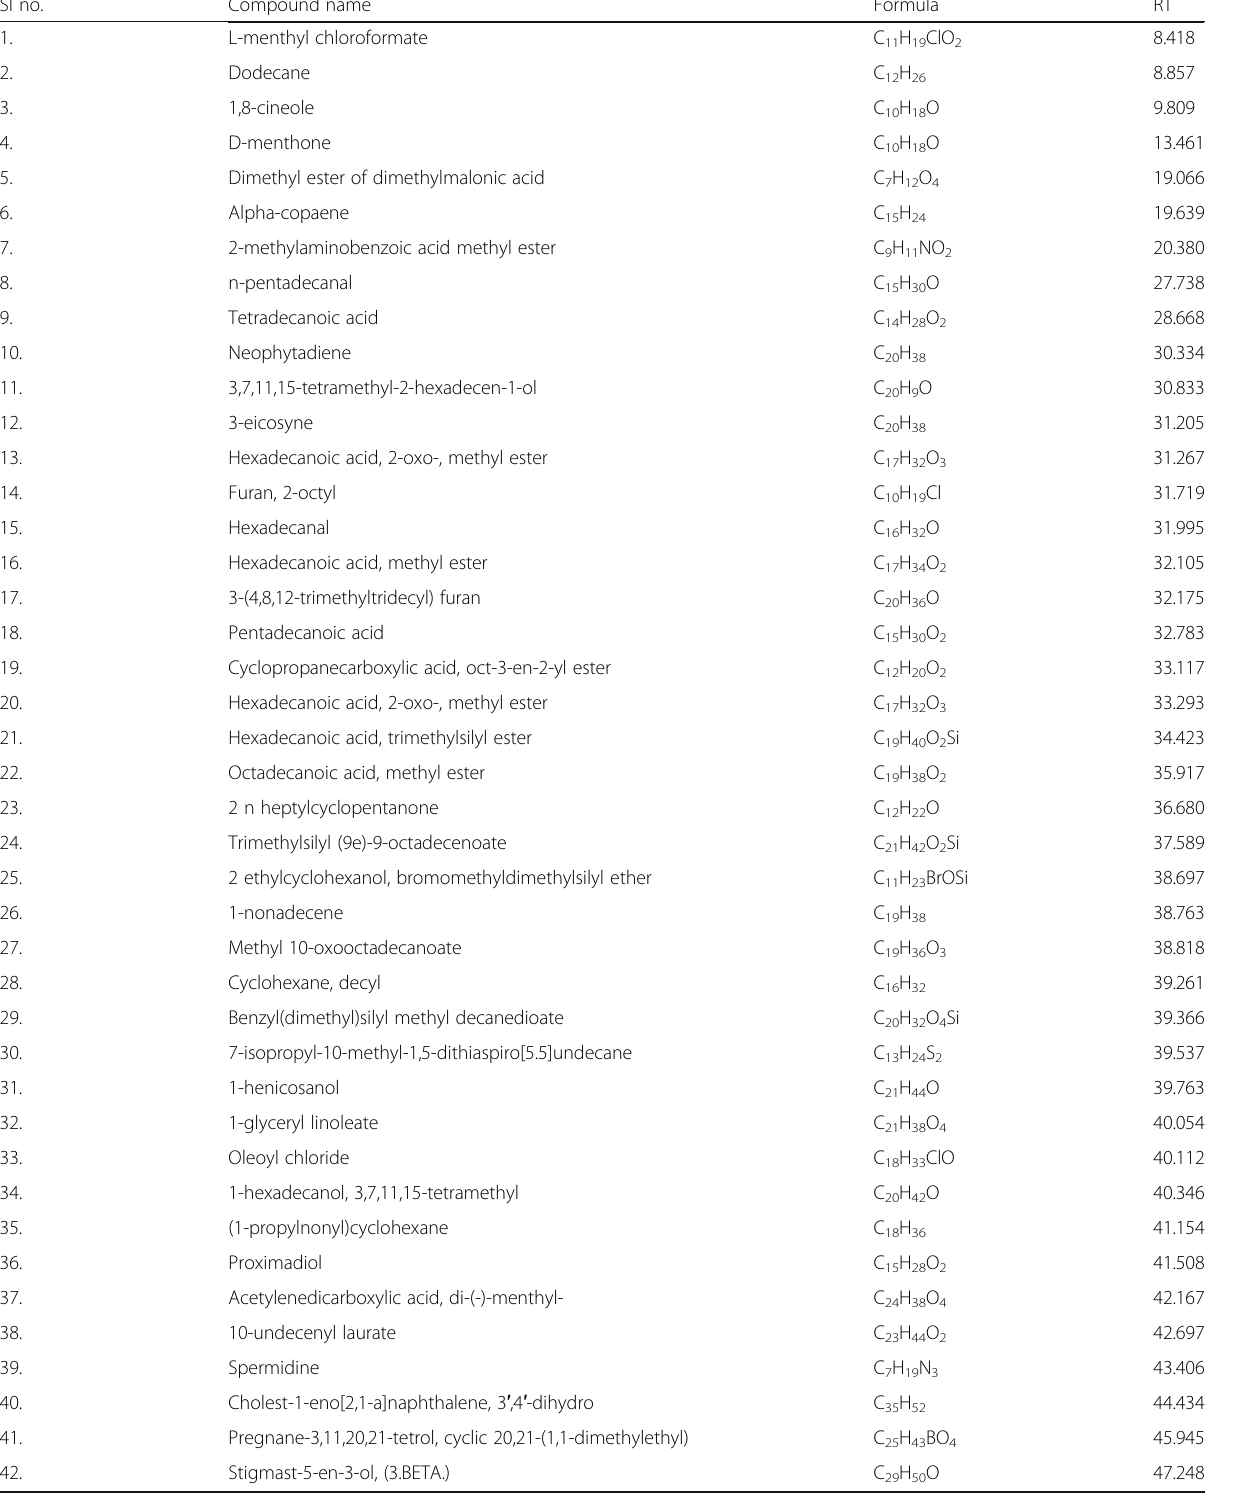
Table 3 List of different active phytochemicals identified by GC-MS analysis of the CML Sl